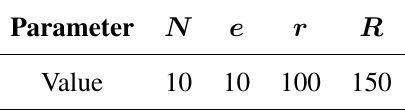
Table 2. Experiment 1 parameter settings.